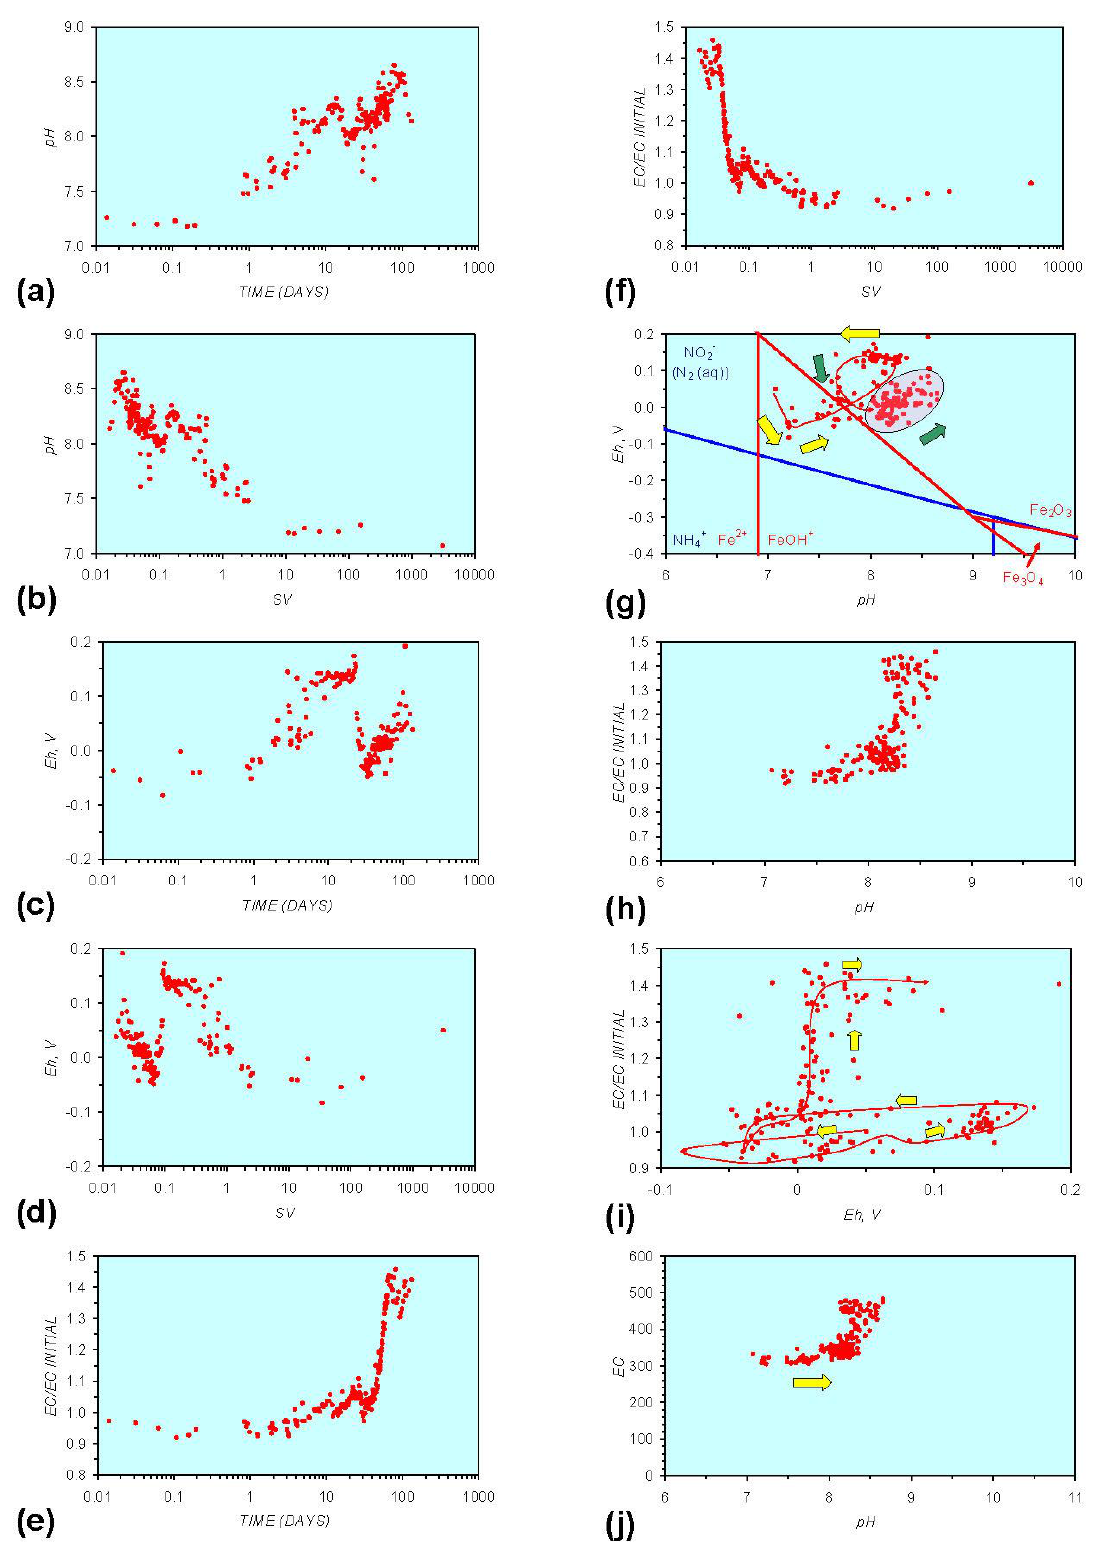
Figure A2. MR2: n-Al 0 , fresh water. (a) pH vs. Time; (b) pH vs. SV; (c) Eh vs. time; (d) Eh vs. SV; (e) EC/EC Initial vs. time; (f) EC/EC Initial vs. SV; (g) Eh vs. pH (SRE ringed); (h) pH vs. EC/EC Initial; (i) Eh vs. EC/EC Initial; (j) pH vs. E(C) Arrows indicate decreasing SV and increasing